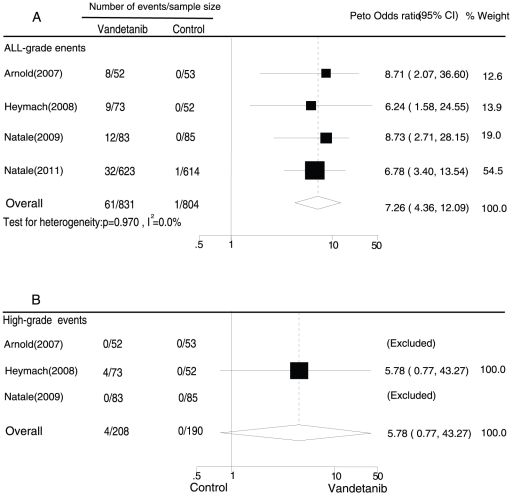
Peto Odds ratio of vandetanib-associated all grade (A) and high-grade (B) prolonged QTc interval versus control from the randomized controlled trials of patients with non-thyroid cancer.